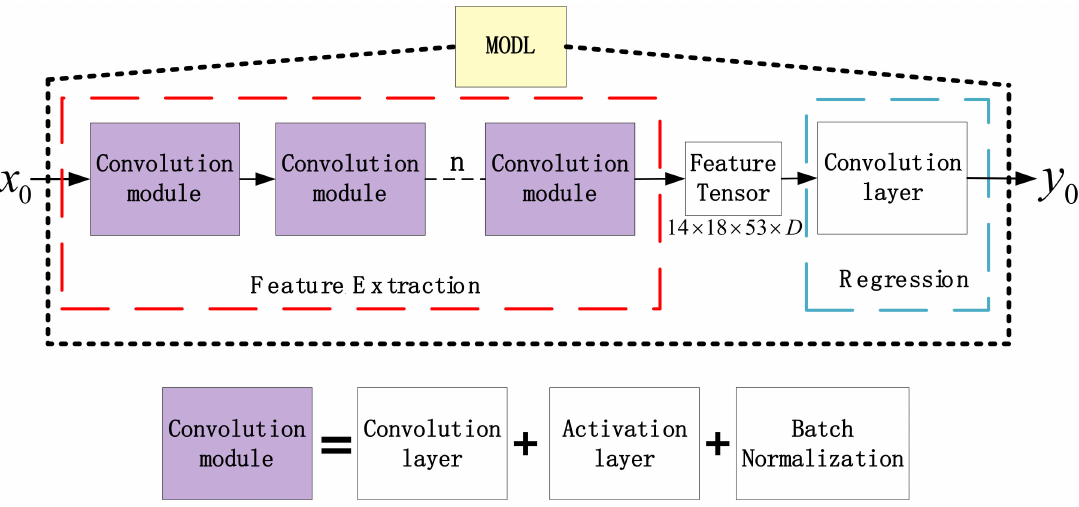
Figure 4. The base framework of MODL.